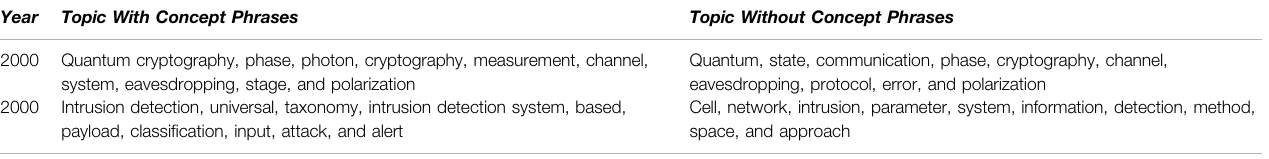
TABLE 3| Thesetwoexamples ofthetop tenterms for atopic from thearXiv topicmodel ofthe DTM conceptswithand withoutcontext conceptphrasesshow thatadding the phrases makes the concepts more easily understood by a person.